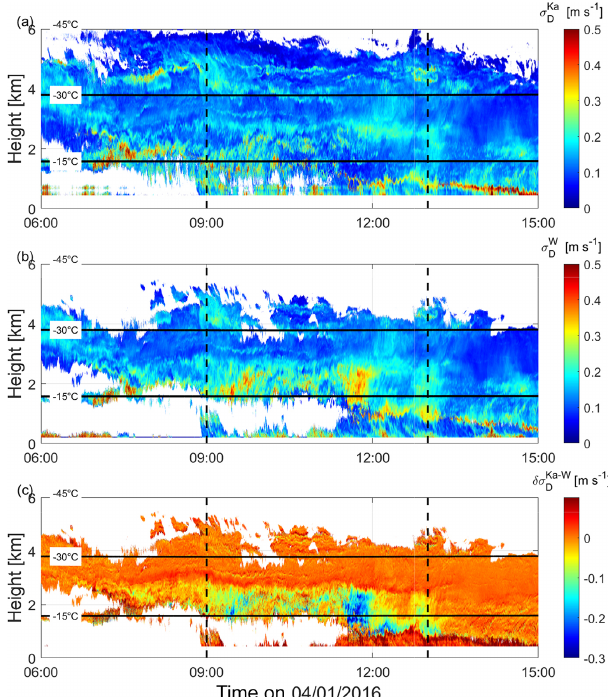
Figure 6. Time–height cross section of the (a) KAZR spectral width σ Ka , (b) MWACR spectral width σ W D spectral width between KAZR and MWCAR δσ Ka , W tal black lines indicate the − 15 and − 30 ◦ C levels while the vertical dashed lines delimit the period of large DWR Ka , W used to produce the density plots in Figs. 7, 8 and